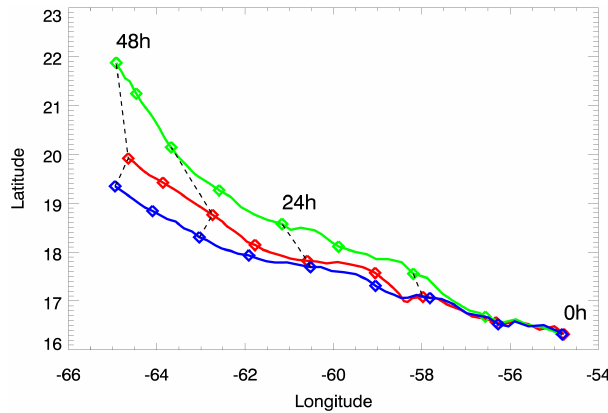
Figure 4. Storm tracks for CTRL (red), MF (green) and MR (blue). Every 6h is identified with a diamond symbol. Black dashed lines connect storm position at the same forecast time for every